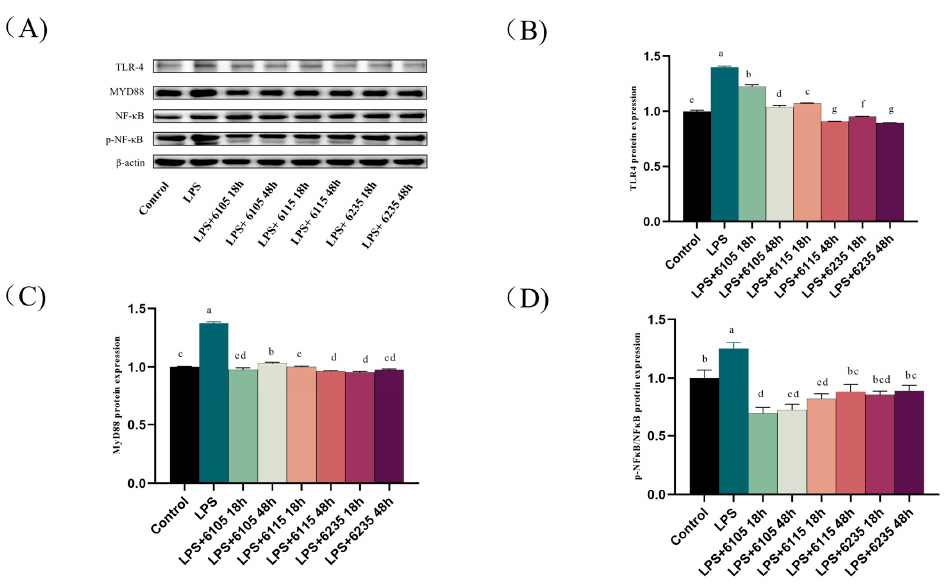
Figure 5. Effects of heat-killed L. paracasei (HK-LP) 6105, 6115, and 6235 (1 µ g/mL) at different cultivation times (18 h or 48 h) on TLR2 ( A ), TLR3 ( B ), TLR5 ( C ), and TLR7 ( D ) mRNA levels in lipopolysaccharide (LPS) (100 µ g/mL)-induced Caco-2 cell monolayers treated with heat-killed L. paracasei (HK-LP) (1 µ g/mL). HK-LP 6105, 6115, and 6235 were incubated for 18 h and 48 h, respectively; after that, they were heat-killed for 30 min at 100 ◦ C. Control: untreated control cells; LPS: LPS-treated cells. Each result is represented as the mean ± standard error of the mean (SEM) from three independent experiments. Different lowercase letters (a, b, c, d) indicate different levels of